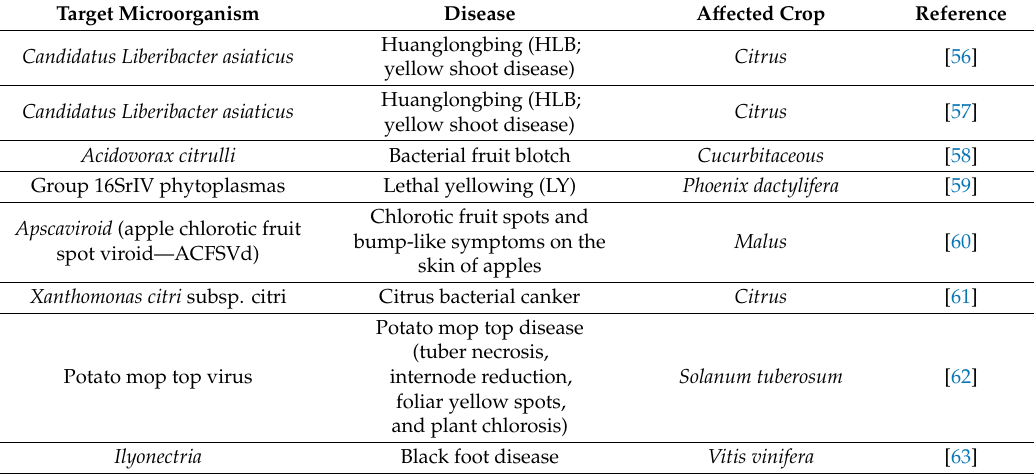
Table 2. The table shows recently developed dPCR assays aimed at identifying and quantifying plant